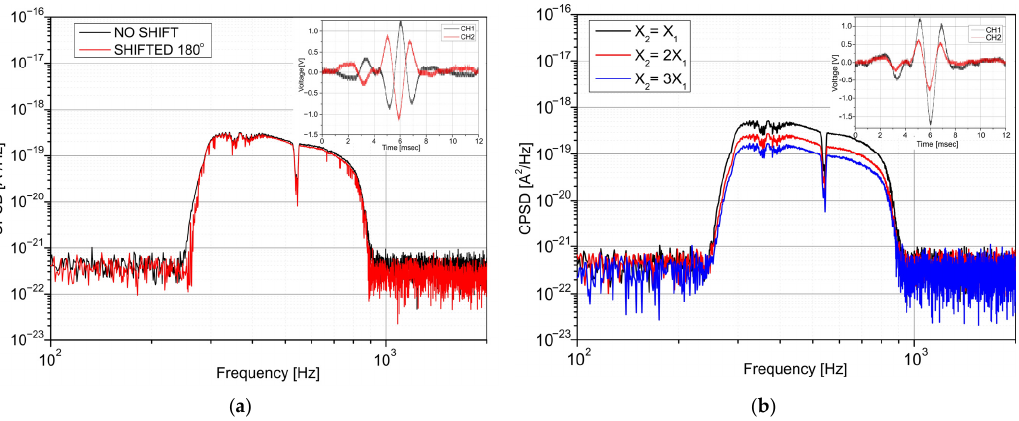
Figure 7. Cross-spectra of two interferograms with different phase shifts ( a ) and amplitudes ( b ). The interferograms’ phase shift (time delay) does not influence the cross-spectra. A tude ratios. The highest level of CPSD was for the interferograms with the same ampli- tudes.